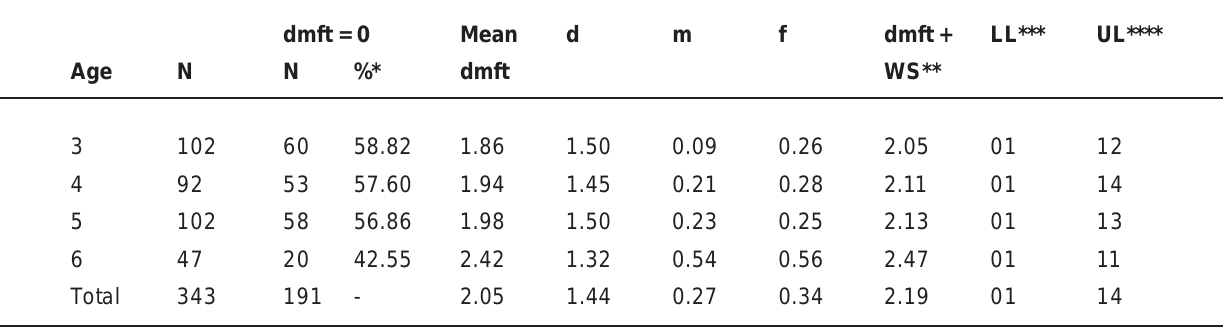
TABLE 1- Mean of dmft index components, according to age and confidence interval of 95%. Federal University of Piauí,